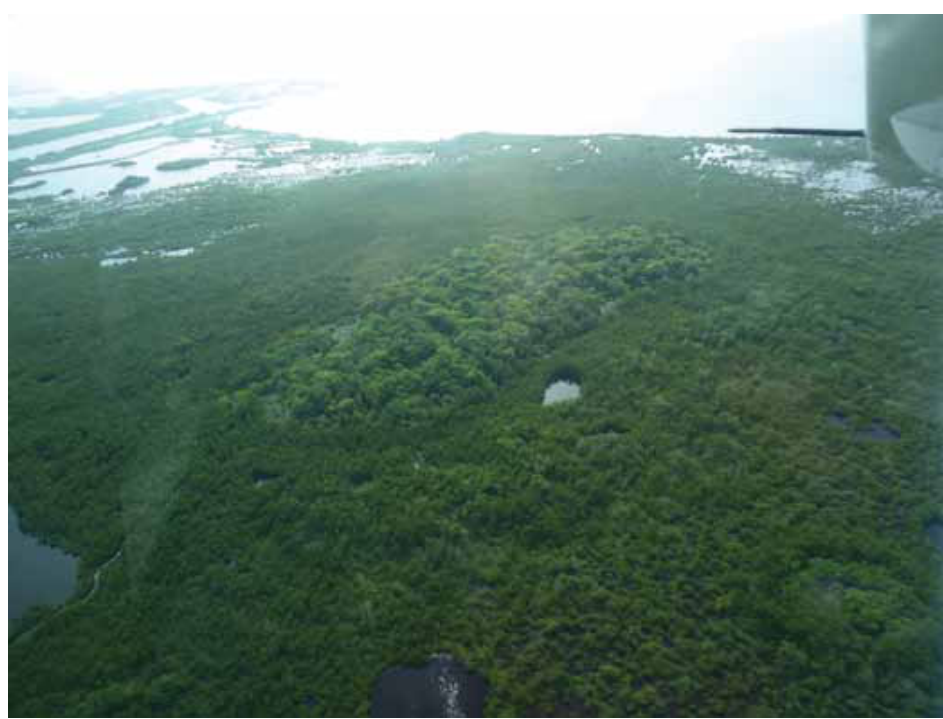
Fig. 2: The Marco Gonzalez site, Belize, at the caye’s southern tip (looking